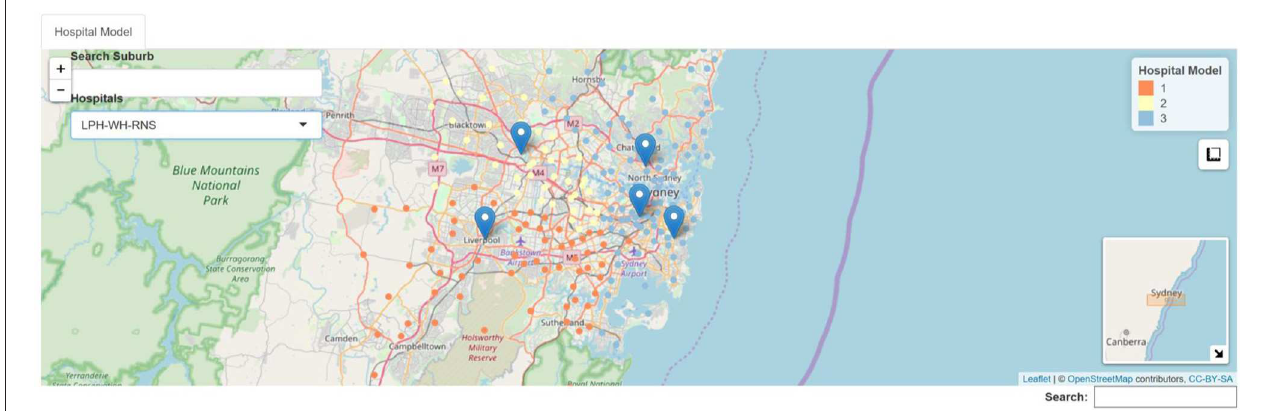
FIGURE 1 | Example of 3 hospital model. RNS, Royal North Shore Hospital, light blue; LPH, Liverpool Hospital, orange; WH, Westmead Hospital, light yellow.